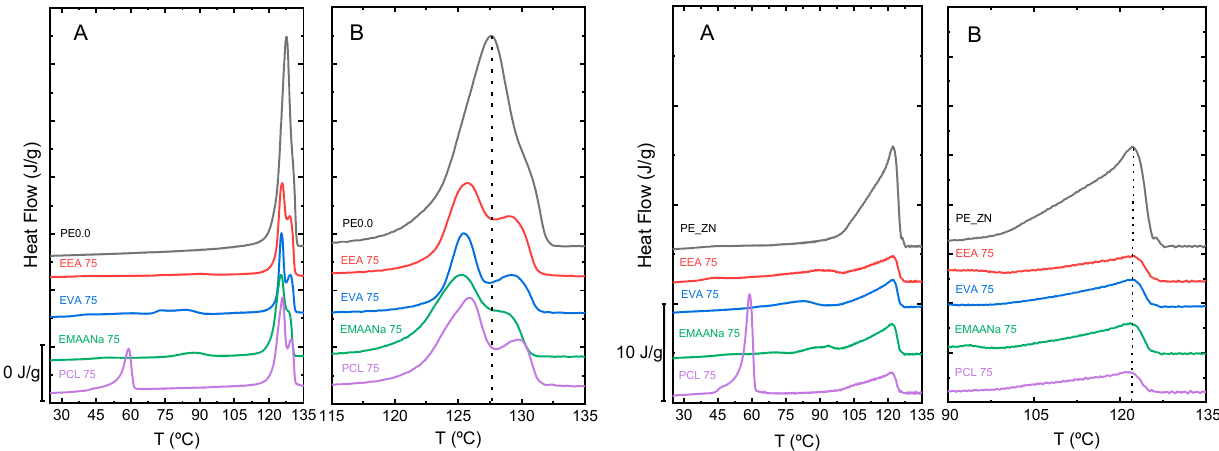
Figure 3. DSC melting traces of PE0.0 ( left ) and PE_ZN ( right ) single crystals mixtures (25/75) with the different branched matrices: ( A ) whole DSC traces and ( B ) detail of PE single crystals melting zone. The dashed line indicates the melting temperature of the corresponding single crystals.